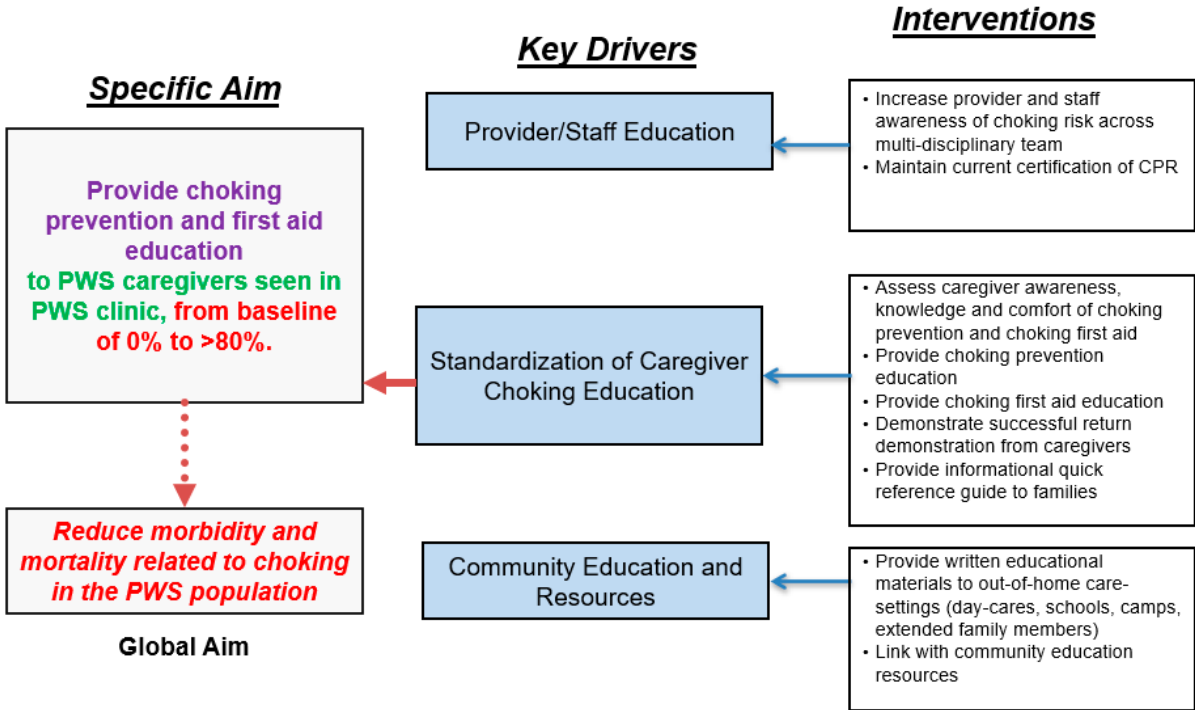
Figure 1. Key driver diagram summarizing the aim, key drivers, and interventions completed during the quality improve- ment study.